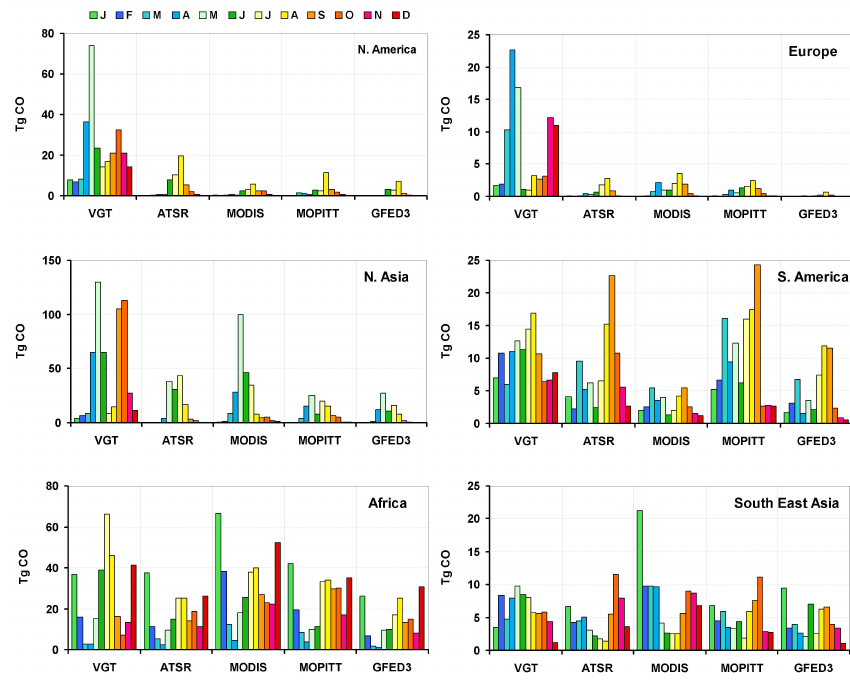
Fig. 2. Seasonality of CO emissions [Tg CO month − 1 ] for each continental window from the five